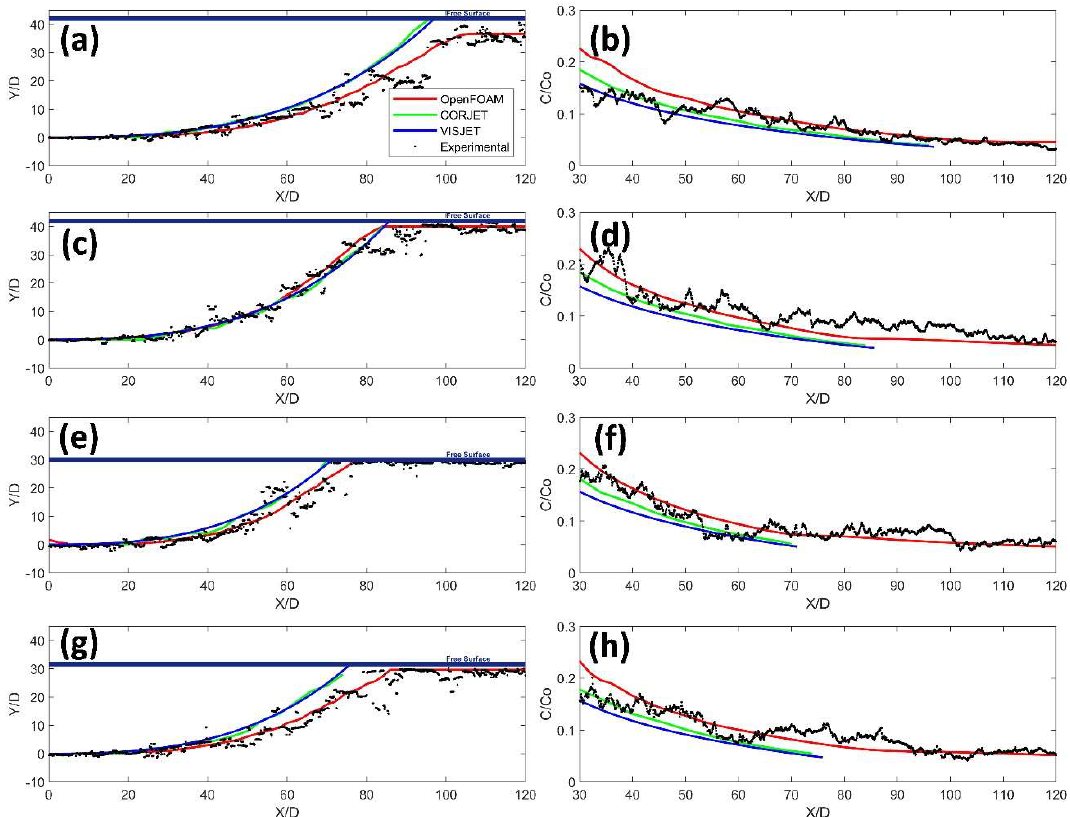
Figure 8. Comparison of the physical results (black dots) versus the numerical results obtained with CORJET (green line), VISJET (blue line) and Open Field Operation And Manipulation model (OpenFOAM) (red line) of the centerline trajectory (left panels) in dimensionless positions (X / D and Y / D) and the C / C MAX along the centerline (right panels) for the physical tests V1 ( a , b ), V2 ( c , d ), V3 ( e , f ) and V4 ( g , h ), respectively.